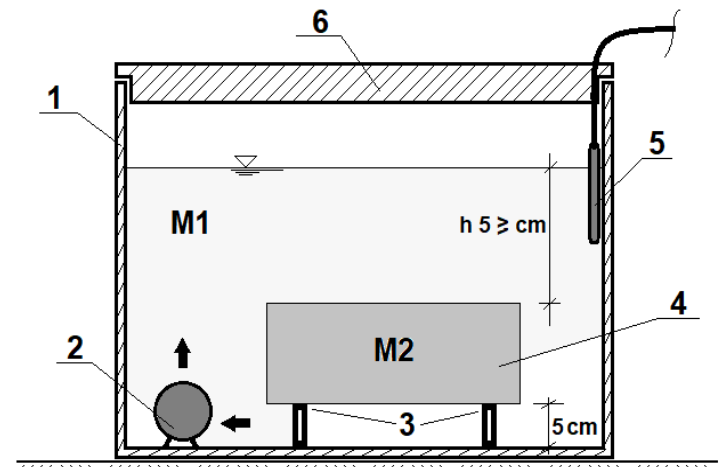
Figure 1. Scheme for washing out Cr (VI) compounds from self-compacting soils (SCS) samples: 1—polyethylene container; 2—circulating water pump to create a flow of flushing water; 3—SCS supporting structure; 4—sample SCS; 5—thermostat for maintaining constant temperature; 6—cover; M1—sample wash water,